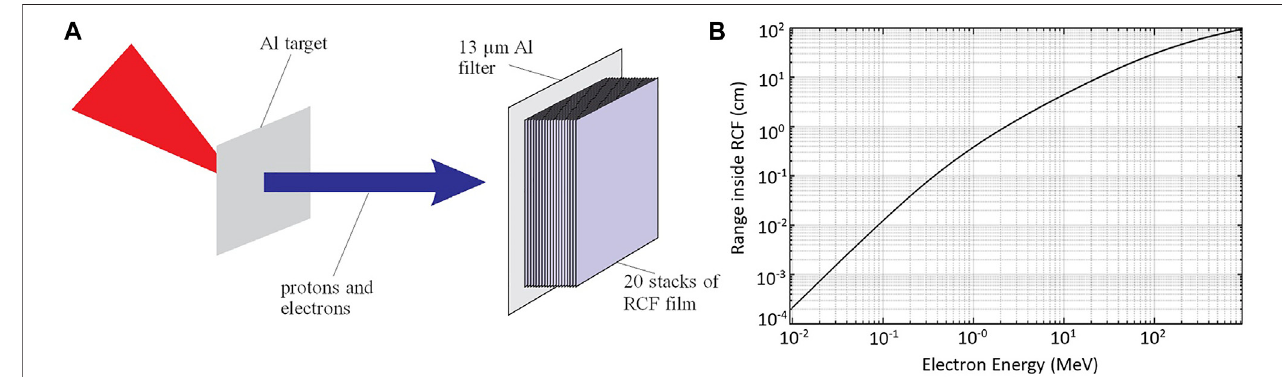
FIGURE 3 | (A) Schematic representation of RCF stack diagnostic fi ltered by 13 μ m Al foil. (B) Penetration range of electrons in the stack as a function of their energy as estimated by the CSDA range from ESTAR database for the substrate material, the main component of the fi lm. Electrons of energies < 90 keV are fi ltered out by the 13 μ m Al